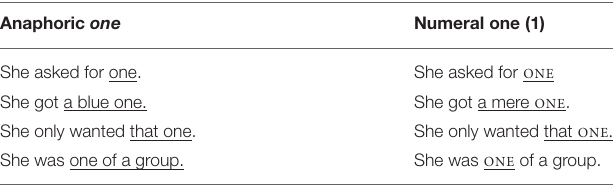
TABLE 1 | Distributional contexts for anaphoric one and the elliptical use of cardinal one . Anaphoric one Numeral one (1)